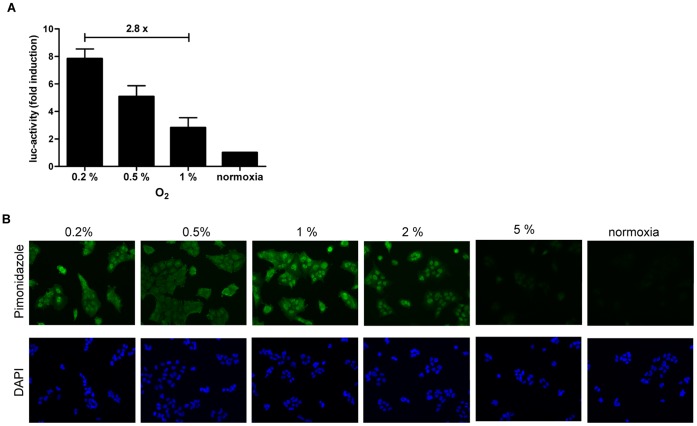
Differential sensitivity for low levels of pO2 by ODD-luciferase and pimonidazole.(A) Luciferase activity in A549 ODD-Luc cells was determined after cellular incubation for 8 hours at different levels of hypoxia and normoxia. Error bars represent mean ±SE. (B) Detection of pimonidazole accumulation in A549 cells incubated at different levels of hypoxia and normoxia. Images display immunocytochemistry staining of pimonidazole and DAPI for nuclear staining (magnification, ×300).